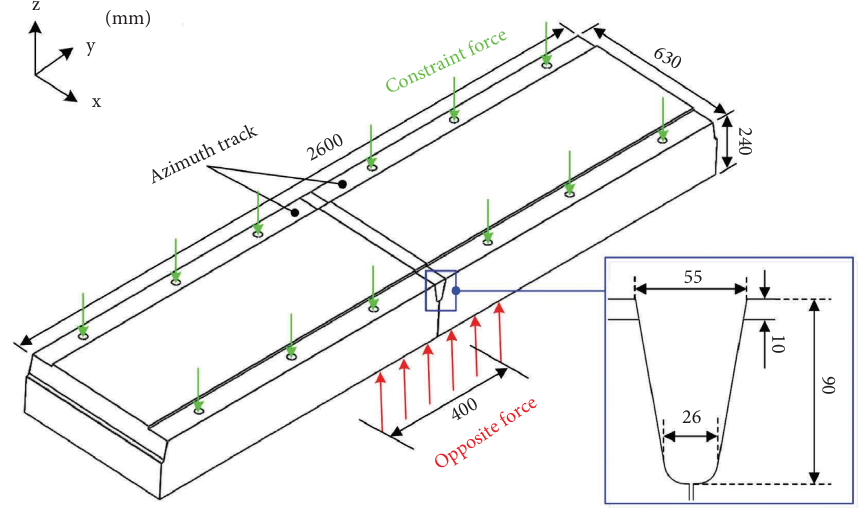
Figure 1: Te 3D model of the antenna’s azimuth track.